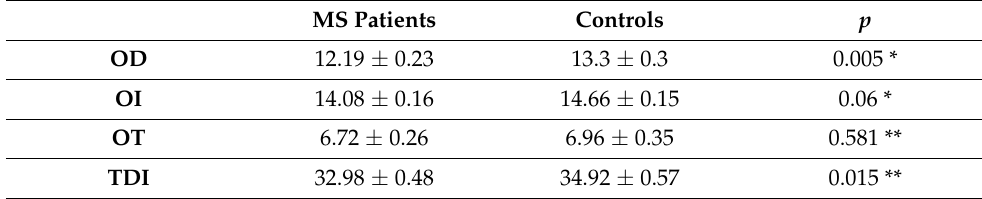
Table 2. The olfactory status of the